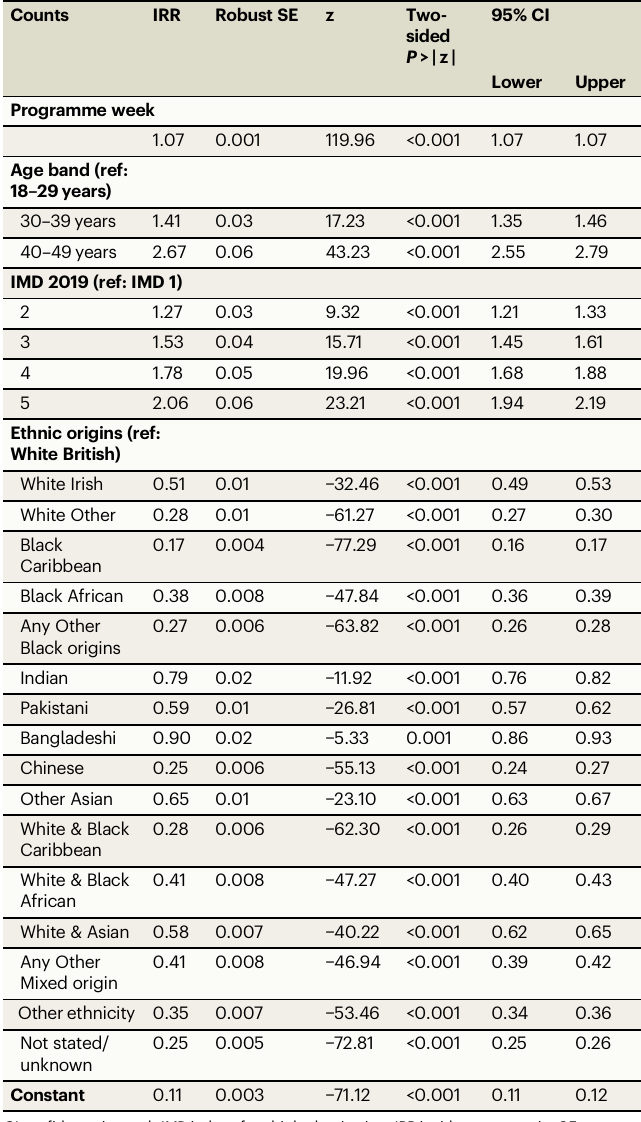
Table 3 | Poisson model examining the impact of maternal age, ethnicity and IMD on ANY vaccine uptake (of at least one